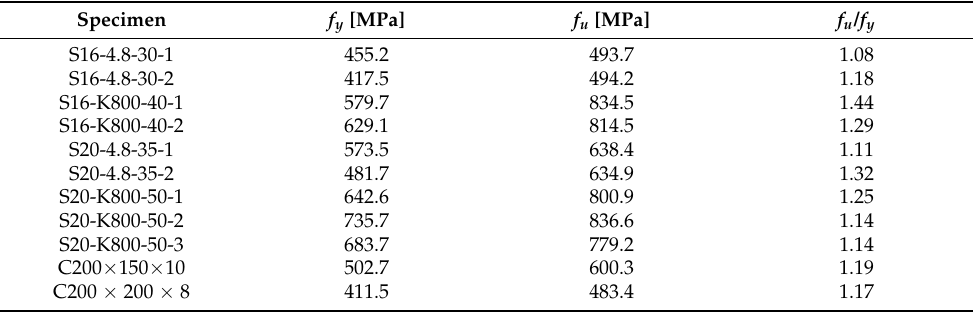
Table 5. Mechanical properties of materials of columns and studs captured in tensile tests.